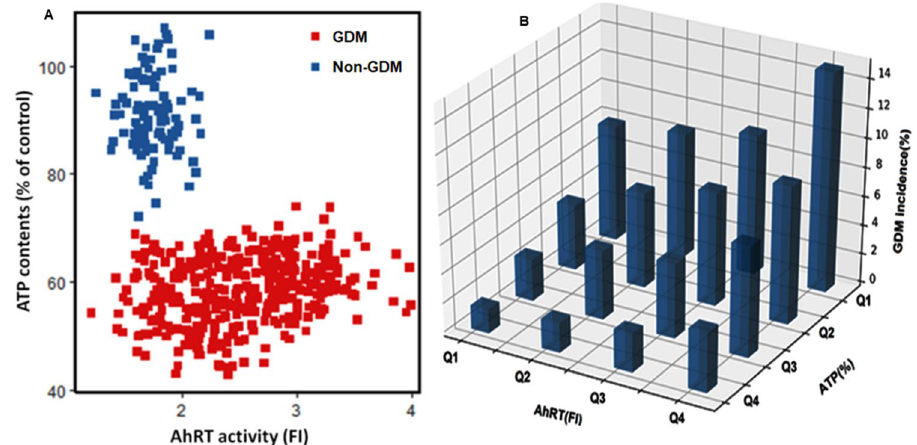
Figure 2. The correlation of serum glucose concentration at 1 h after 50 g glucose challenge, aryl hydrocarbon receptor transactivating (AhRT) bioactivity, and ATP concentration. ( A ) Relationship between AhRT bioactivity (FI) and ATP contents (%). ( B ) The proportion of GDM (%), according to the quartiles of AhRT activity (FI) and ATP concentration (%). GDM proportion was calculated by the number of women with GDM divided by the total number of women in each quartile. AhRT bioactivity was measured by the modified CALA assay using the serum from 390 GDM and 100 non-GDM participants. AhRT activity was presented as fold induction (FI) over the AhRT of the 10% CS-HS-treated control cells. ATP concentration of 10% sample serum-treated cells was measured by a CellTiter-Glo luciferase kit. It was calculated as % of ATP content in control cells treated with 10% CS-HS-treated control cells.